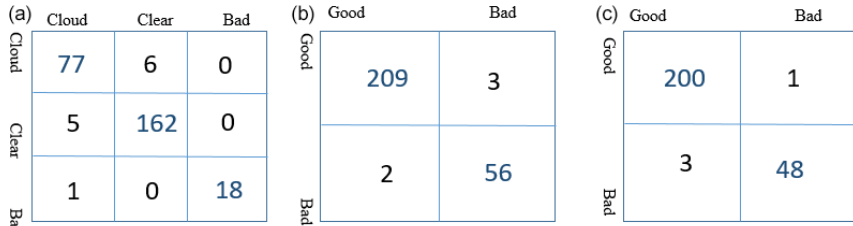
Figure 3. The confusion matrices for nitrogen channel (a) , LR channel (b) , and HR channel (c) . In a perfect model, the off-diagonal elements of the confusion matrix are zeros.